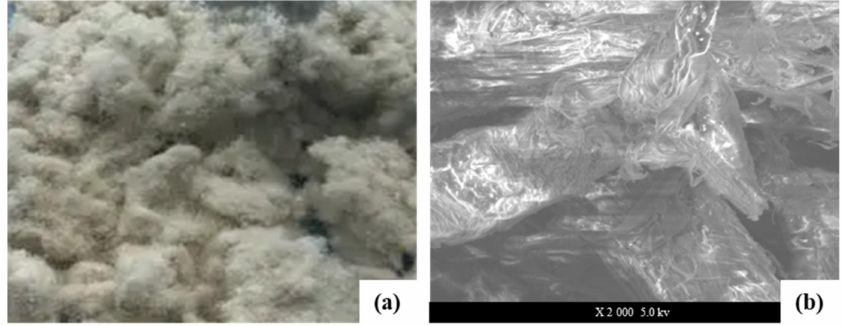
Figure 5. Lignin fiber ( a ), microstructure of lignin fiber ( b ).